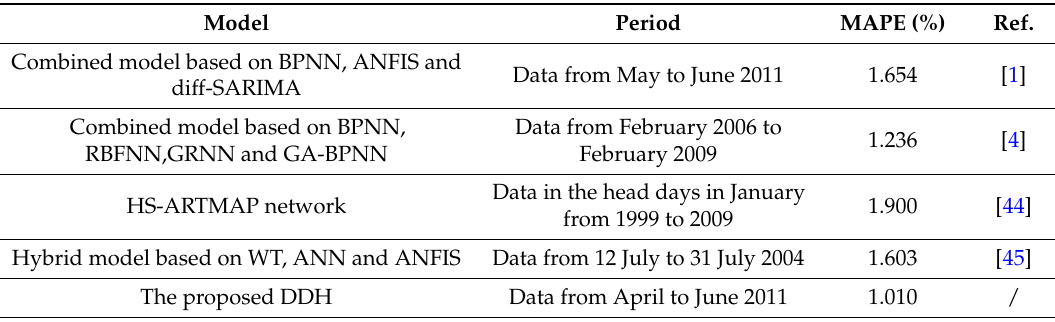
Table 6. Comparison of MAPE with models in the literature. Model Period MAPE (%) Ref. Combined model based on BPNN, ANFIS